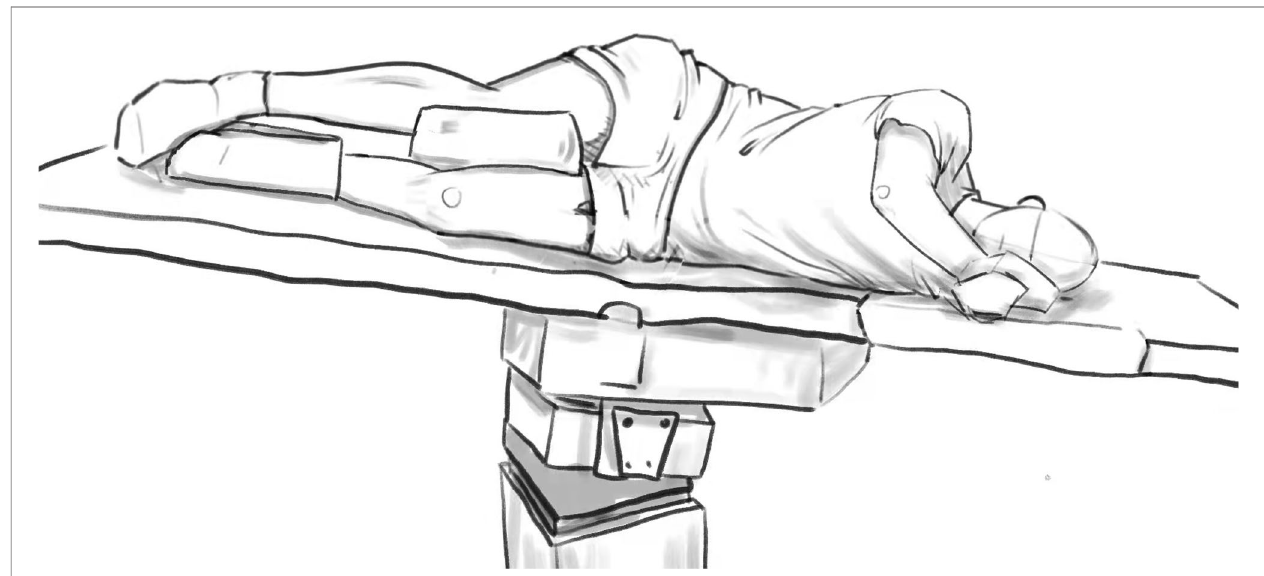
FIGURE 2 | Durant ’ s position (left side down with head-down); This picture is hand drawn by the